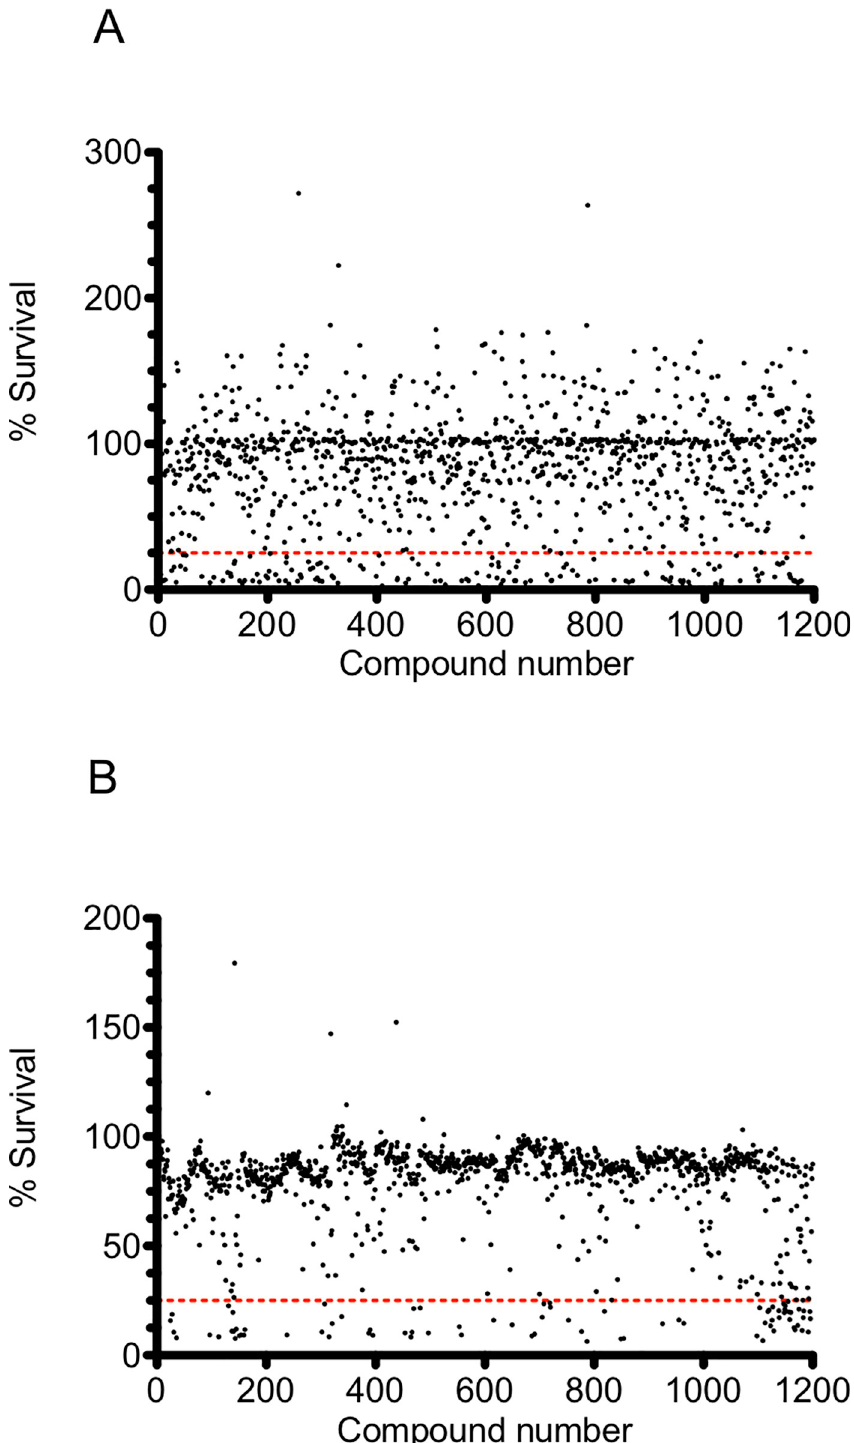
Fig 1. Primary screening of the Prestwick Chemical Library compounds against M . smegmatis (A) and BCG (B) using a GFPMA assay. GFP measurements were recorded after a defined period of incubation of mycobacteria in the presence of 20 μ M compound from the Prestwick Chemical Library. Data was normalised to control wells and is expressed as mean % survival from n = 2 biological replicate experiments. The red dashed line depicts < 25% cell survival as determined by residual GFP